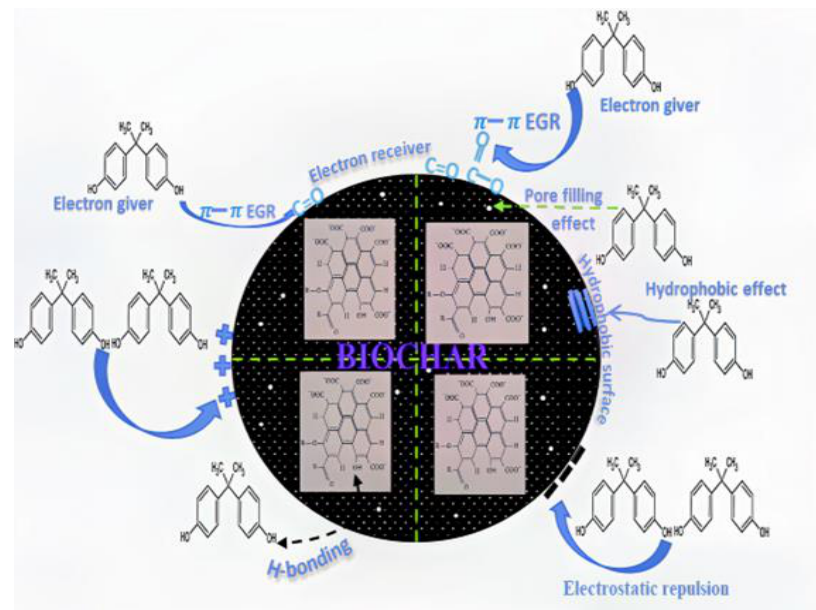
Figure 17. Schematic coordination of BPA removal mechanism using biochar.